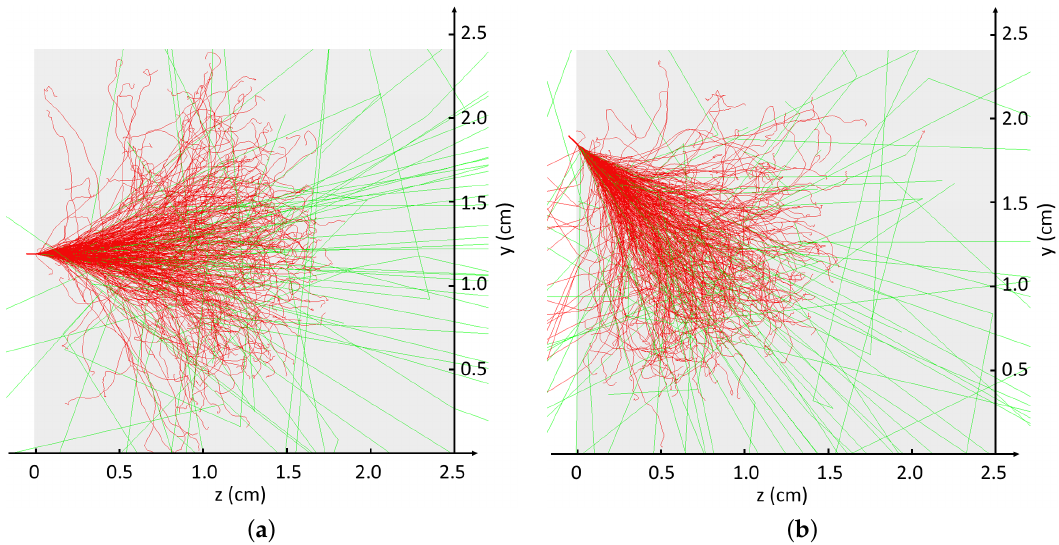
Figure 10. Irradiation with 3.5 MeV at ( a ) 0 ◦ and ( b ) 45 ◦ angle beams. The red/green lines are the trajectories of elec- trons/photons. The grey colour is 2.5 cm thick (from left to right) water.